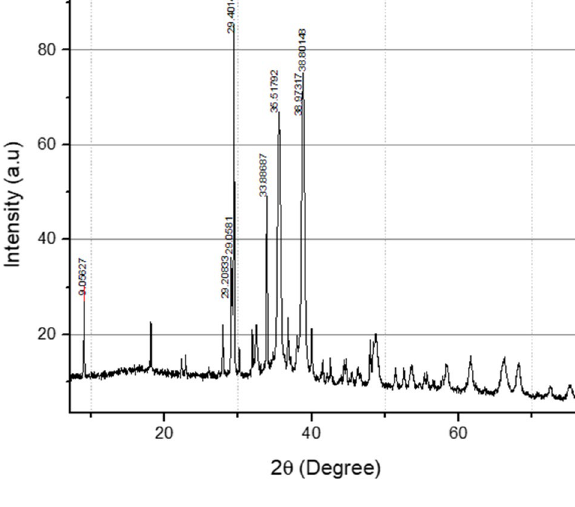
Fig. 4 XRD Pattern of synthe- size ZnO